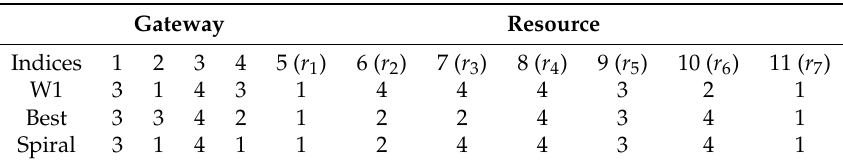
Table 4. An example of spiral function.